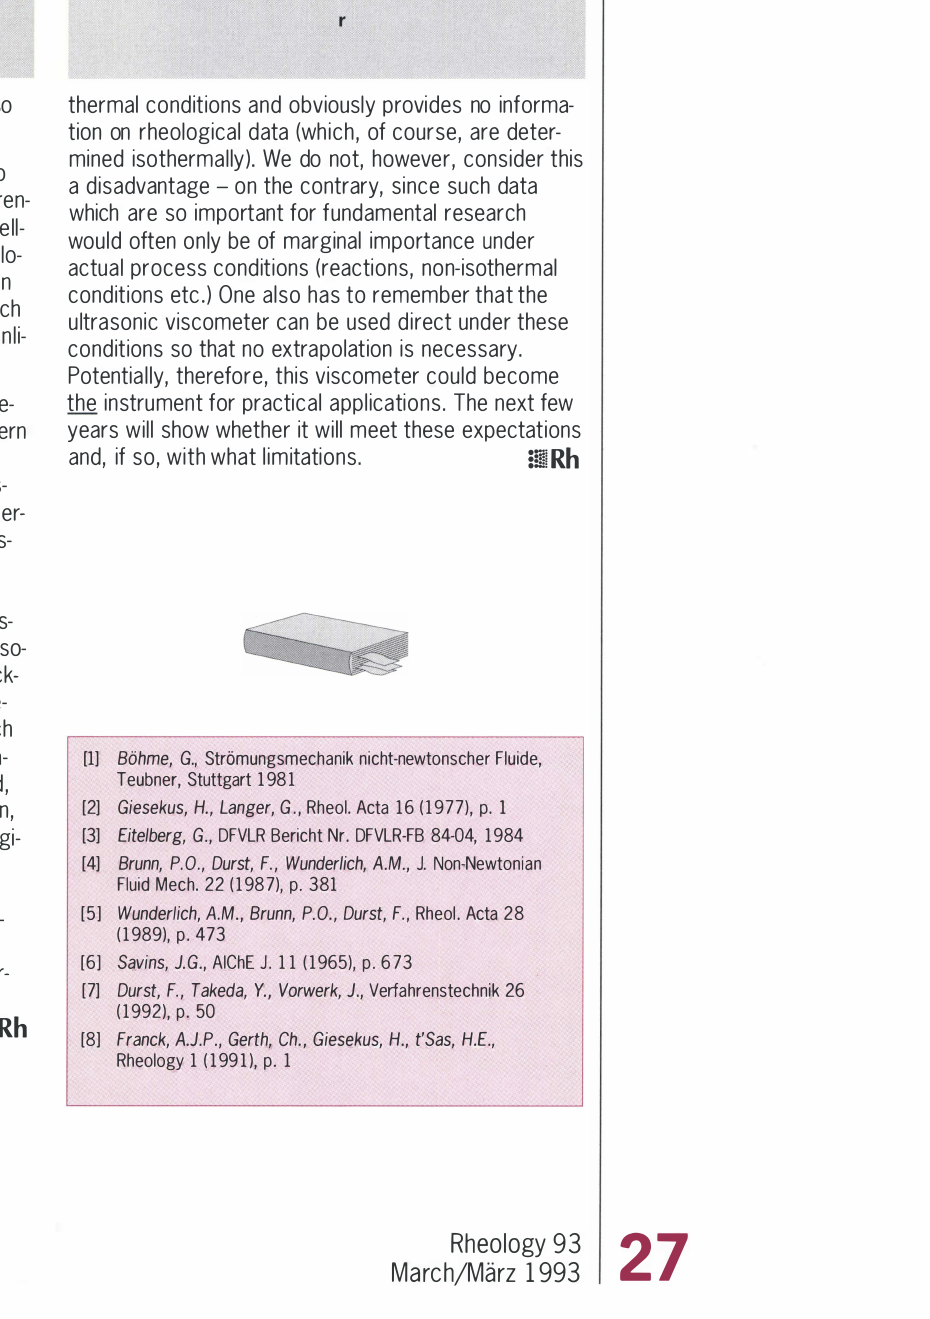
Fig. 6: Schematic profile of velocity distribution of a complex liquid in a tubular